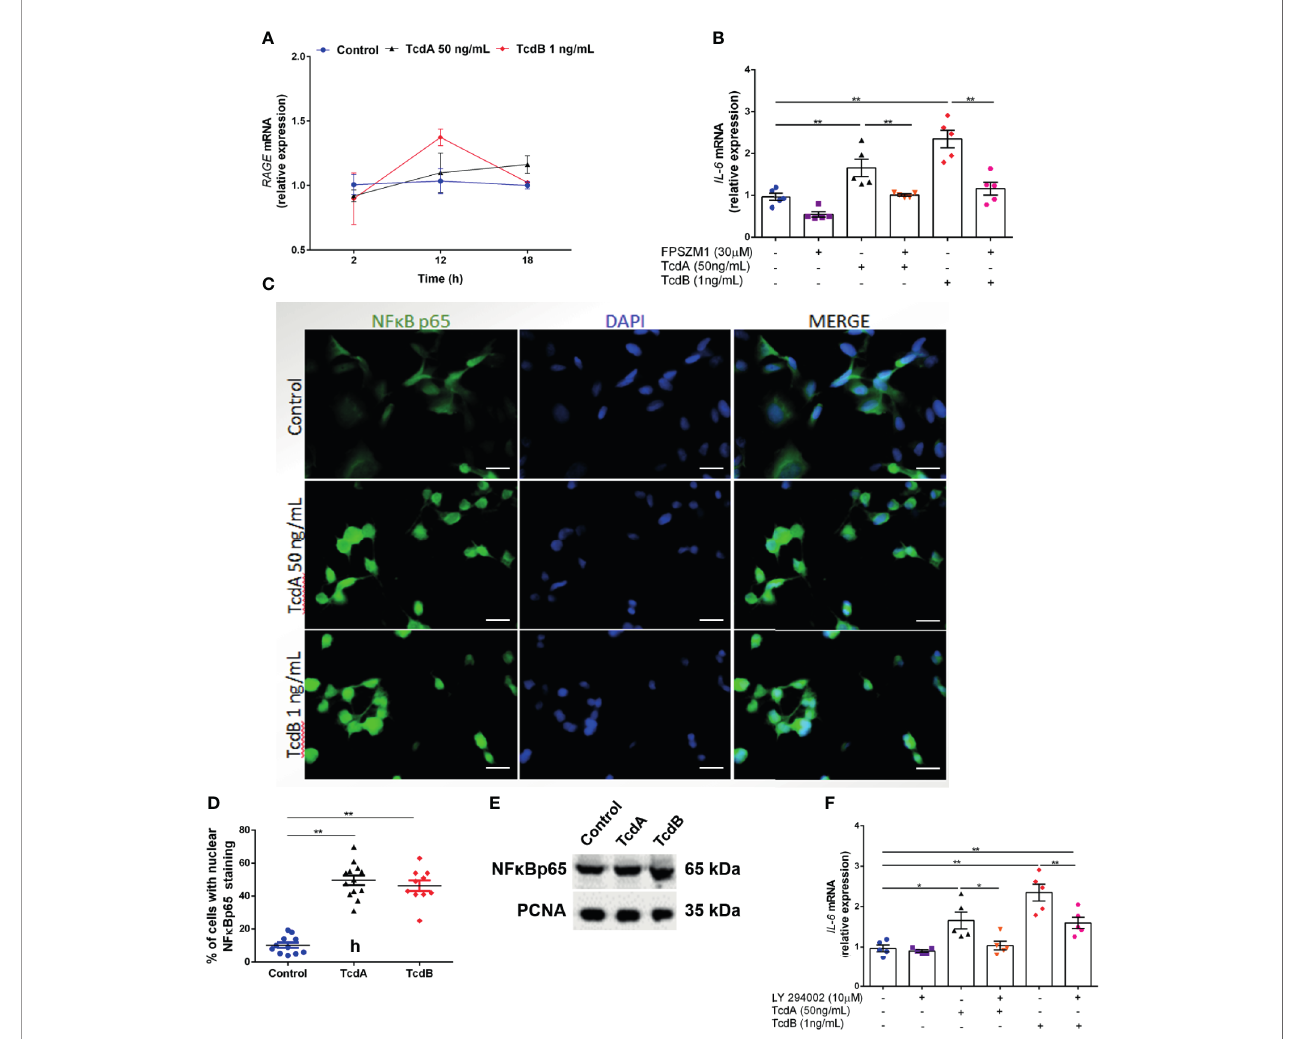
FIGURE 6 | Blockade of the S100B receptor and PI3K decreases C. dif fi cile toxin-induced IL-6 upregulation in EGCs. (A) RAGE gene expression (mean ± s.e.m) by qPCR in enteroglial cells (EGC/PK060399) challenged with TcdA and TcdB (n = 4). (B) Analysis of IL-6 gene expression (mean ± s.e.m) by qPCR in enteroglial cells (EGC/PK060399) challenged with TcdA and TcdB for 18 h in the presence or absence of 30 m M FPSZM1 (a RAGE antagonist) which was added 1 h prior to C. dif fi cile toxin challenge. (C) Representative photomicrographs of NF k Bp65 (green) immunostaining and DAPI (blue) nuclear staining in enteroglial cells (EGC/ PK060399) exposed to TcdA and TcdB after 18 h of incubation. (D) Percentages of cells (mean ± s.e.m) with positive nuclear NF k Bp65 staining under different experimental conditions at 18 h of incubation with TcdA and TcdB. (E) Western blot (WB) bands of NF k B p65 and PCNA in nuclear extract fraction of enteroglial cells (EGC/PK060399) exposed to TcdA and TcdB at 18 h of incubation. (F) Analysis of IL-6 gene expression (mean ± s.e.m) by qPCR in enteroglial cells (EGC/ PK060399) challenged with TcdA and TcdB for 18 h in the presence or absence of 10 m M LY294002 (a PI3K inhibitor) which was added 1 h prior to C. dif fi cile toxin challenge. (A – F) Cells receiving only supplemented DMEM was applied as a control. (B, F) Experiments were performed with the same negative (Control) and positive controls (TcdA and TcdB). **p < 0.0001. ANOVA followed by (B, D, F) Turkey test was used. *p <